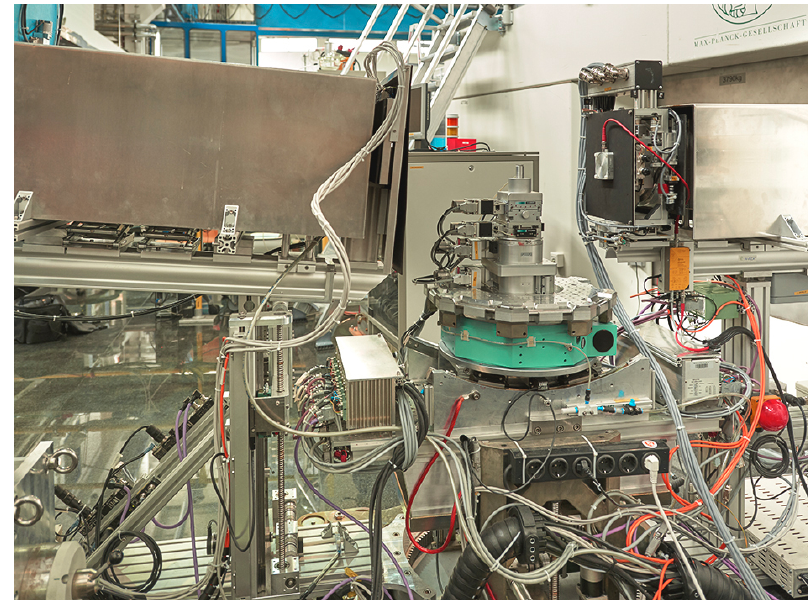
Figure 1: Instrument NREX (Copyright by W. Schürmann,